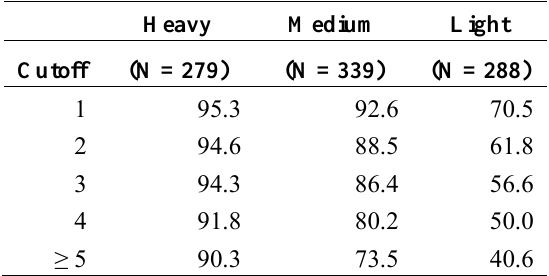
Table 7. Accuracy of urban classes (Heavy, Medium, Light) using a cutoff of number of pixels from 1 to a ≥ 5 (a clear majority) of 9 pixels in each 90 m × 90 m reference assessment polygon for the final 2002 land cover